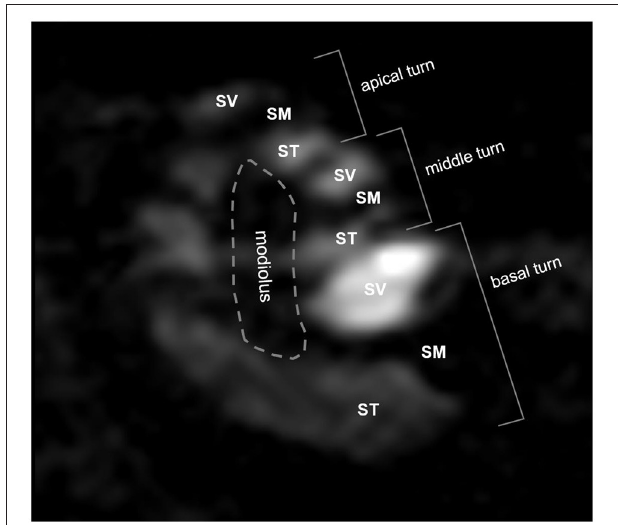
FIGURE 1 | Three-dimensional magnetic resonance imaging of rat cochlea at 2h after intratympanic (IT) gadolinium (Gd)-diethylenetriamine pentaacetic acid (DTPA) injection. Although the scala tympani ( ST ) and scala vestibuli ( SV ) were enhanced by Gd, the scala media ( SM ) was not. Based on this enhancement pattern, we were able to identify the three compartments (ST, SV, and SM) and the three turns (apical, middle, and basal) of the cochlea. The signal intensity (SI) in each compartment in each turn was quantified for further comparison between the